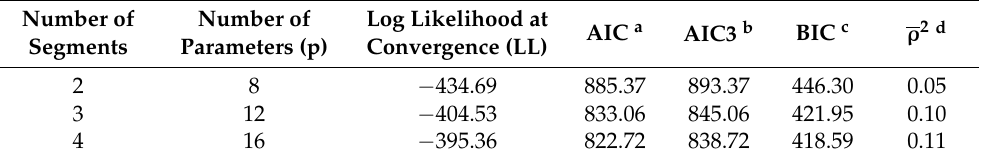
Table 3. Statistics to determine the optimal number of consumer segments.